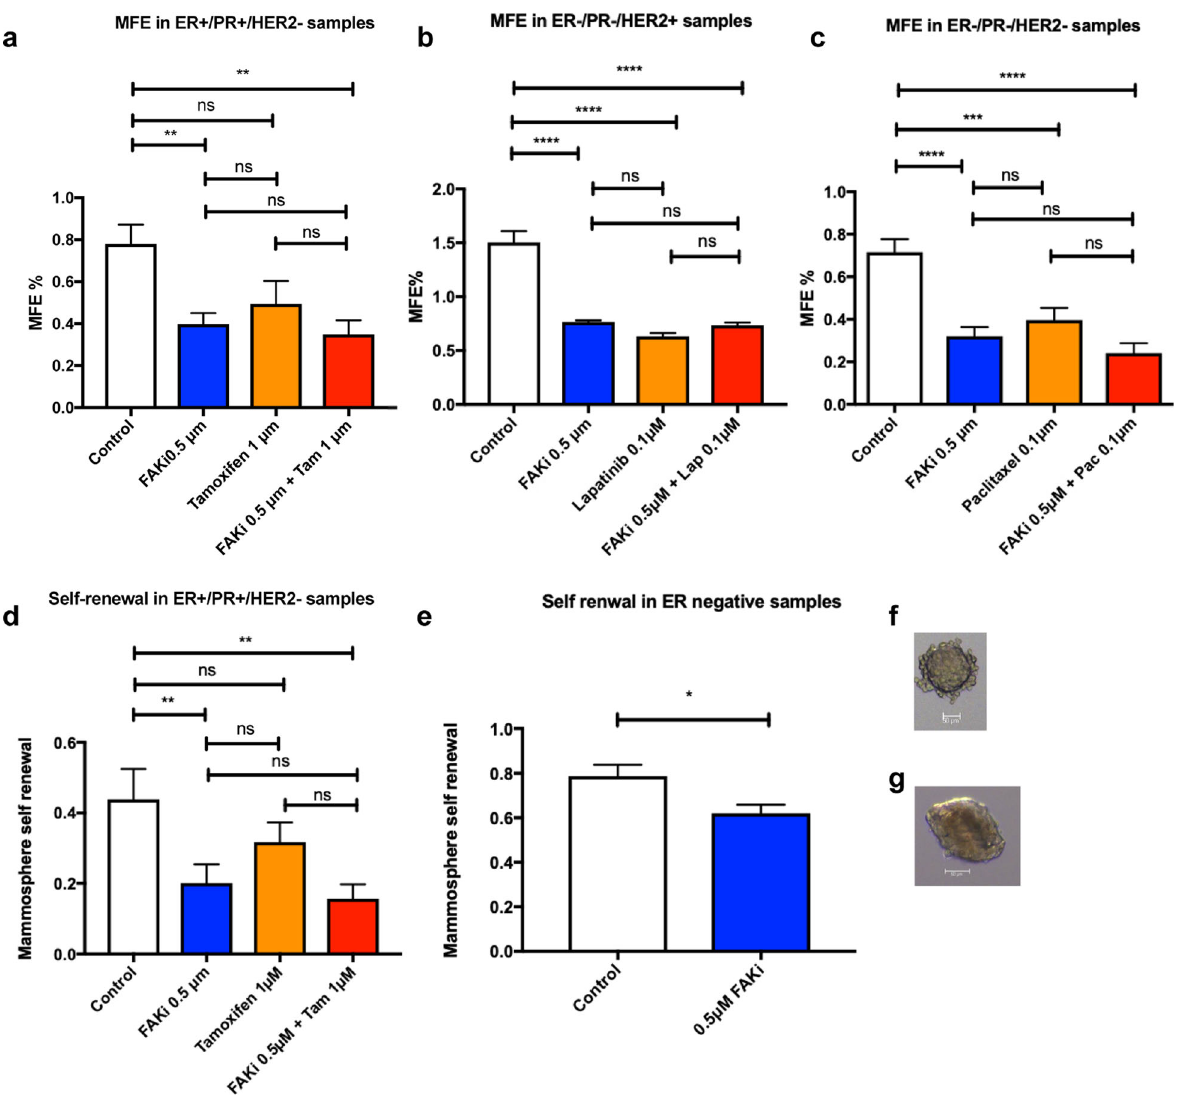
Fig. 3 FAK inhibition reduces primary and secondary sphere formation across all molecular phenotypes in patient samples. a FAK inhibition with 0.5 μ M VS4718 reduces primary mammosphere formation in 16 ER + /PR + /HER2 − patient samples. b 0.5 μ M VS4718 and 0.1 μ M Lapatinib reduced primary MFE in four ER − /PR − /HER2 + patient samples. c 0.5 μ M VS4718 and 0.1 μ M Paclitaxel reduced primary MFE in six ER − /PR − /HER2 − patient samples. Each patient had a minimum of six technical replicate values for MFE. d Graph demonstrating that FAK inhibition reduces mammosphere self-renewal in eight ER + /PR + /HER2 − samples. Data in ( a – d ) analysed using Two-way ANOVA with post hoc Tukeys test. e Graph demonstrating that FAK inhibition in ER negative patient samples reduces mammosphere self-renewal. Unpaired two-tailed t -test. (ns not signi fi cant, * p < 0.05, ** p < 0.01, *** p < 0.001, *** p < 0.0001). All error bars represent mean + SEM. Photomicrographs taken at ×40 magni fi cation of ( f ) primary patient mammosphere after VS4718 treatment ( g ) secondary mammosphere in DMSO group with 50 µM scale